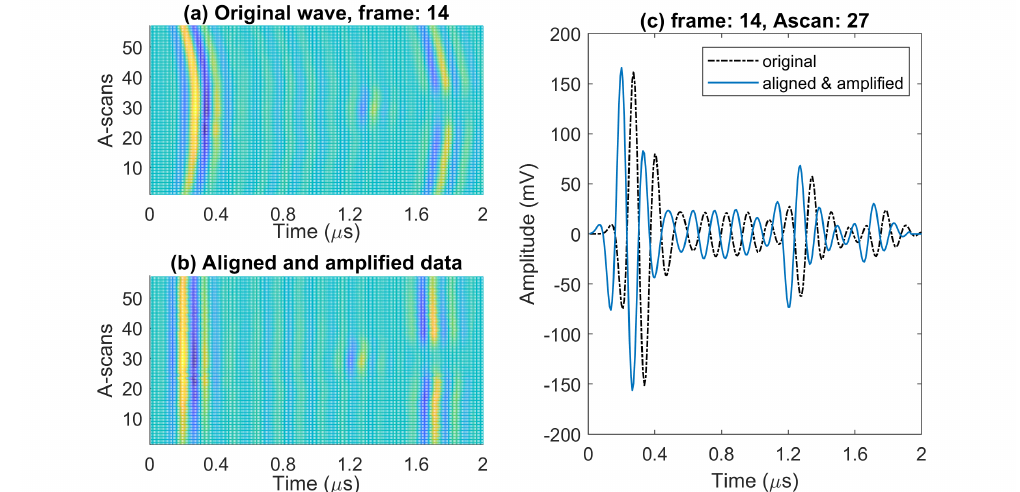
Figure 5. Post processing of a frame (with defect echoes) at 10 MHz: ( a ) before, and ( b ) after applying initial processing techniques (alignment, and linear slope gain), and ( c ) A-scan from defective region before and after alignment and